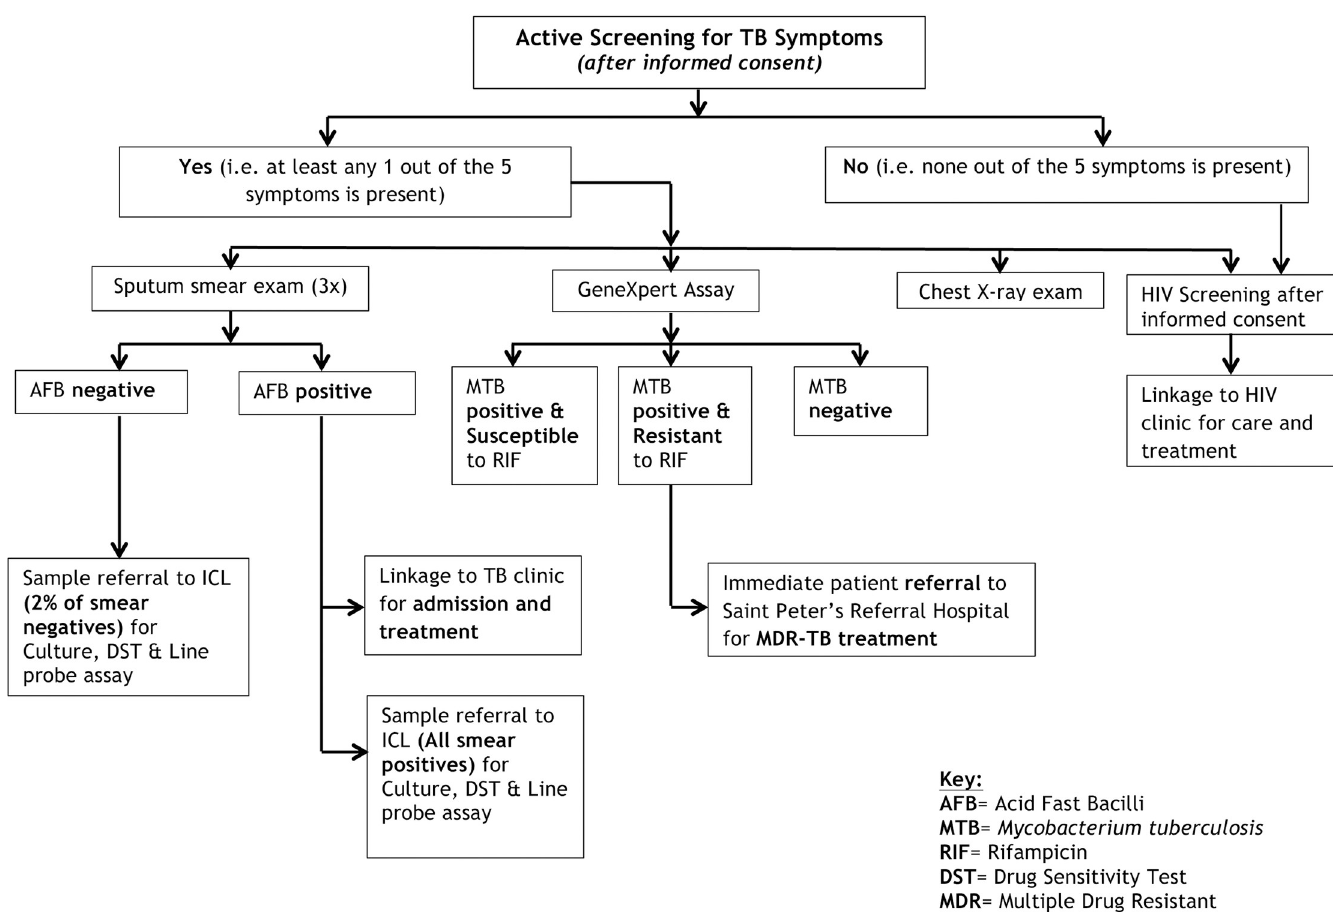
Fig 1. Work flow for TB